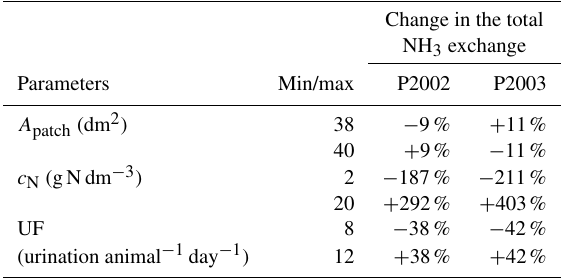
Table 7. Results from the baseline simulations with GAG_field when the maximum and minimum was applied of the investigated parameters. In every simulation the difference in the total NH 3 ex- change was derived, expressed as the percentage of the total ex- change in the baseline simulations with